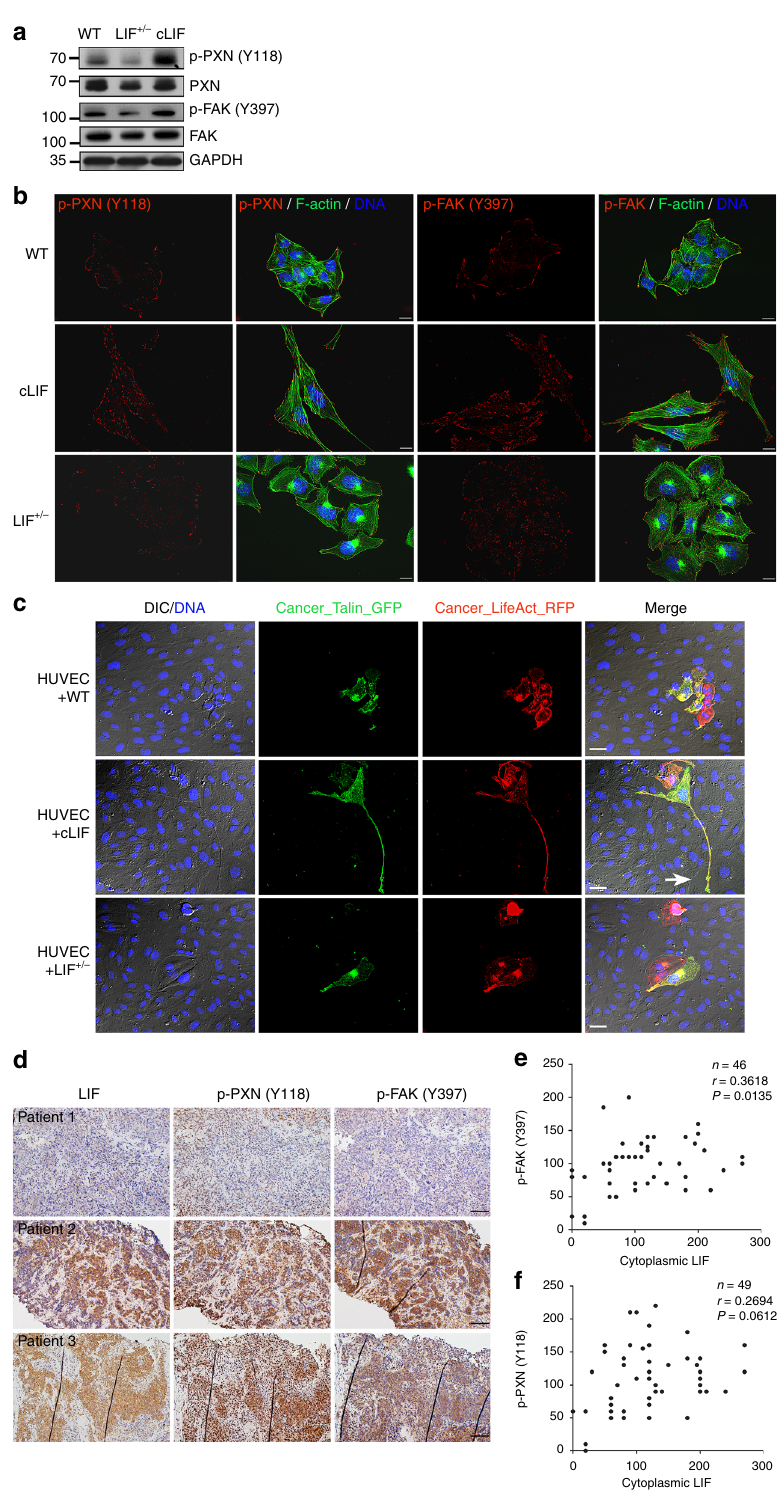
Fig. 5 LIF regulates focal adhesion molecules. a Detection of endogenous focal adhesion kinases in cancer cells via western blot using GAPDH as a loading control. b LIF regulates the spatial distribution of activated focal adhesion kinases. Cells were labeled with antibodies against phospho-PXN (Y118) or phospho-FAK (Y397). Alexa Fluor 488 phalloidin (green) was used to stain F-actin. Blue, nuclear staining. Scale bars, 10 μ m. c Live imaging of focal adhesion during transendothelial invasion. Cancer cells expressing LifeAct-RFP were pre-labeled with Talin-GFP and plated onto the HUVEC layer. Images were captured 24 h post-plating. Blue, nuclei labeled with Hoechst33342. Scale bars, 20 μ m. The white arrow indicates the damaged area caused by Talin- rich elongated protrusion. d Representative images of LIF, p-PXN (Y118), and p-FAK (Y397) expression in paraf fi n-embedded consecutive NPC tissue sections. Scale bars, 50 μ m. e , f Correlation analyses based on IHC scores (Spearman ’ s correlation test). Correlations were evident between LIF and p-FAK (Y397) ( e ) and LIF and p-PXN (Y118) ( f